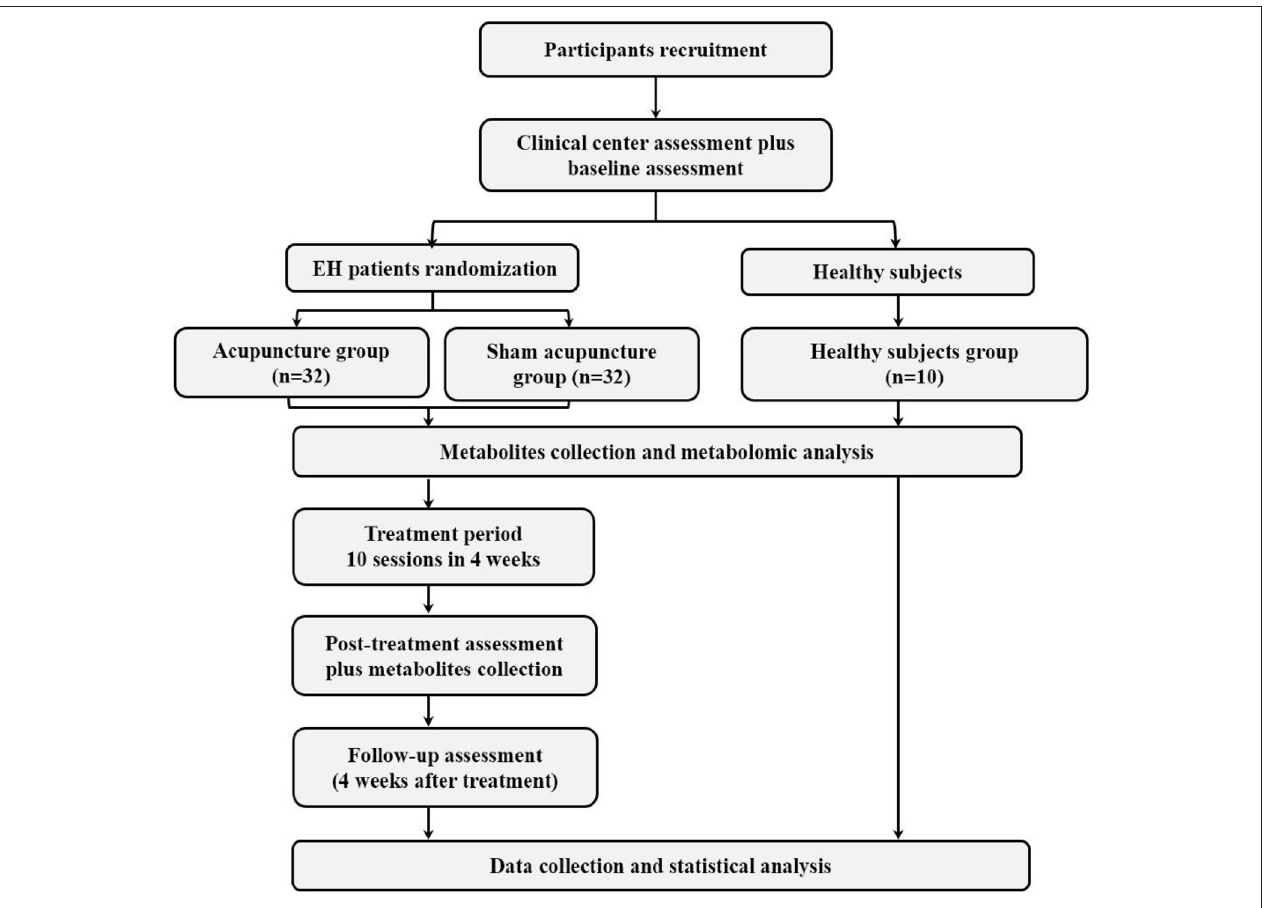
FIGURE 1 | Flowchart of the trial